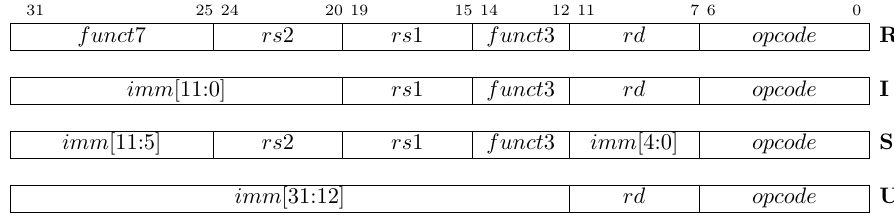
Figure 8: Base RISC-V instruction